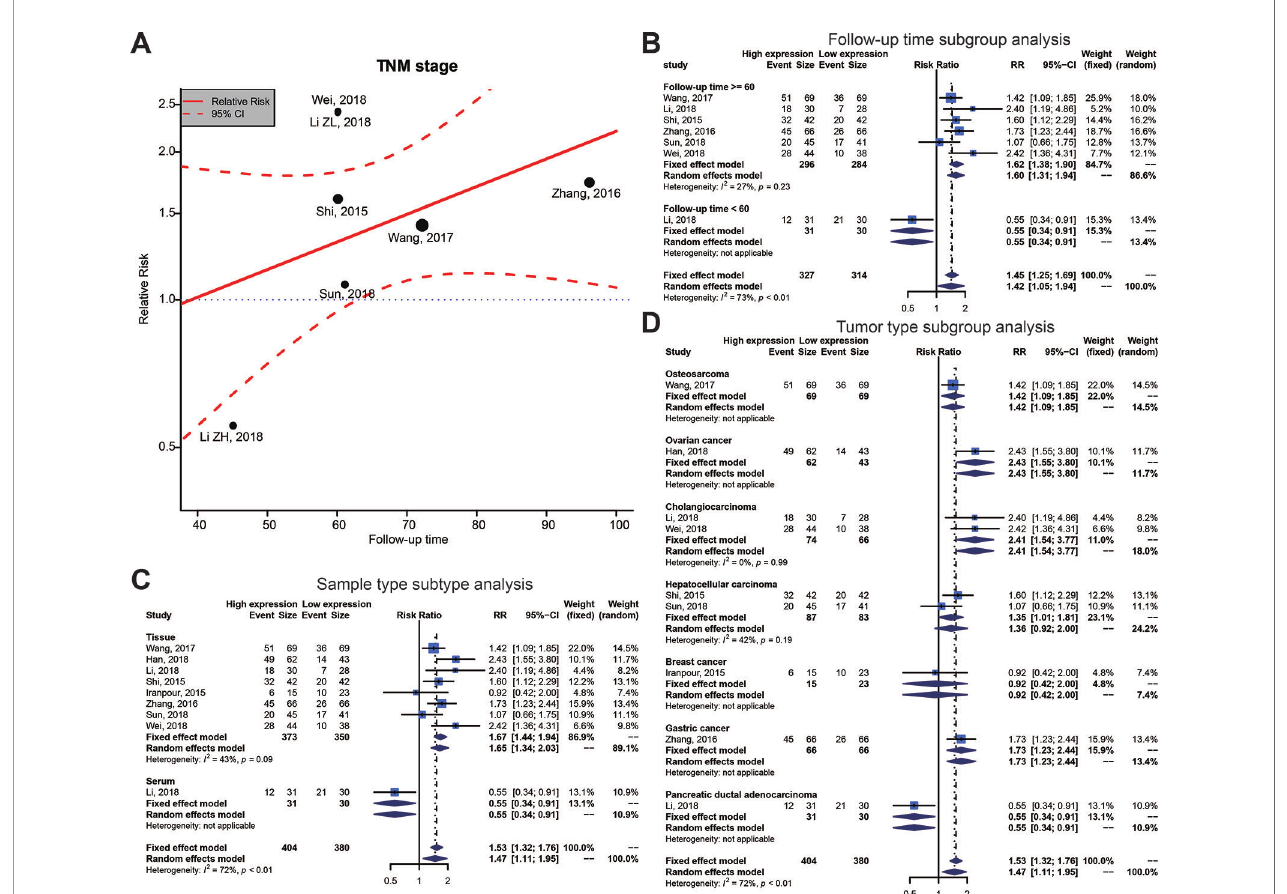
FIGURE 5 | Meta-regression plot and subgroup analysis of tumor, node, metastasis (TNM) stage and follow-up time, sample type and tumor type. (A) Meta- regression plot correction of follow-up time and TNM stage. From the meta-regression plot correction, we determined that a follow-up time of more than 60 months correlated with higher TNM stage. The point of determination for differences in TNM stage is a follow-up time of about 60 months. (B) Follow-up time subgroup, (C) sample type subtype, and (D) tumor type